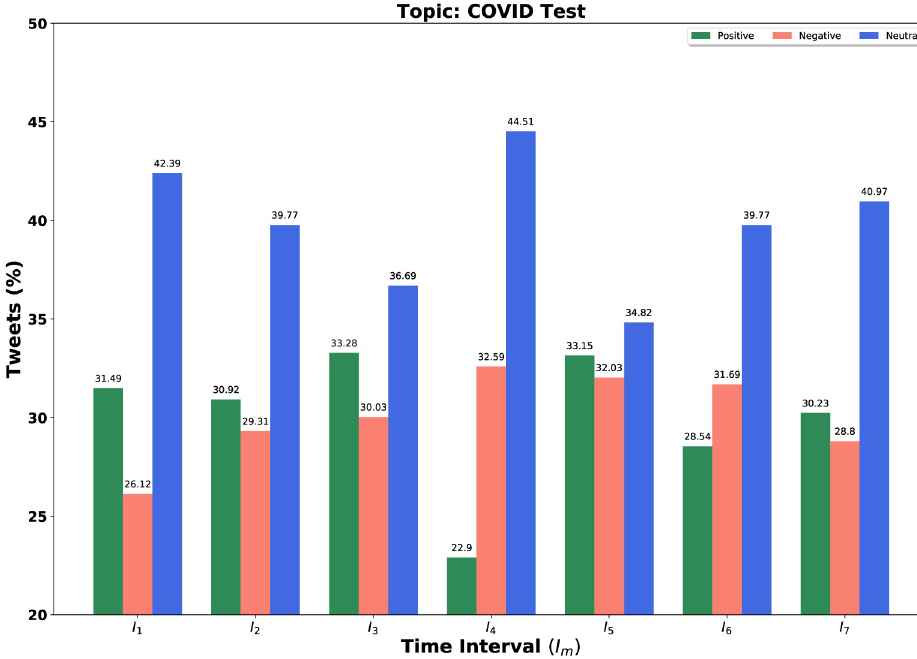
Fig 6. Overall sentiment dynamics on Twitter at different time intervals I